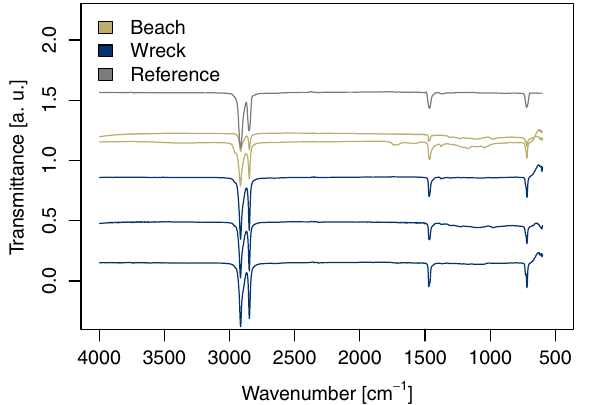
Figure 2. Fourier-transform infrared spectra measured on the inside of MP resin pellets from a beach in the Wadi el Gemal national park, Egypt, and the SS Hamada wreck in the Red Sea. By comparison with a reference database, most MP were identified as LDPE. Their carbonyl index (1810–1550 cm -1 ) and the fingerprint area (< 1500 cm -1 ) revealed chemical modifications only in the case of MP from the